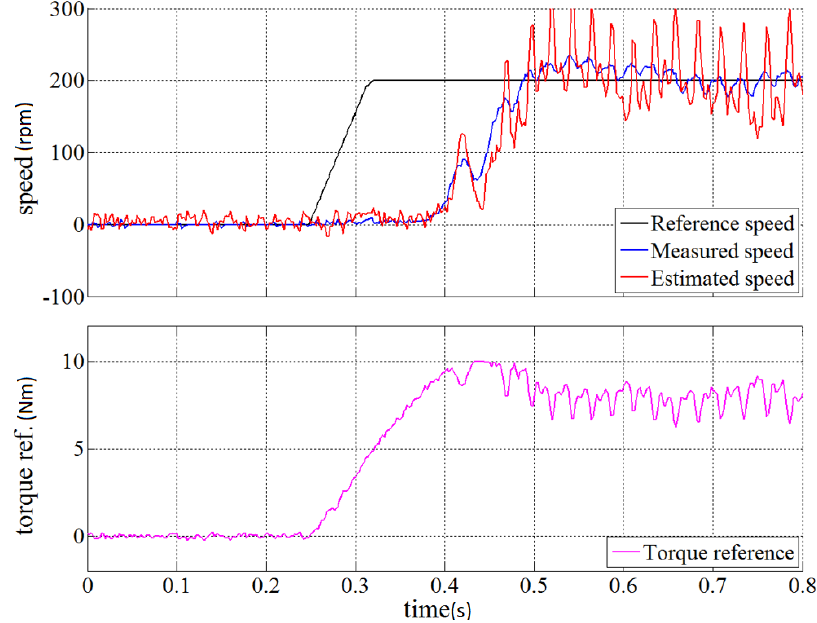
Figure 23. Motor #1: Increased bandwidth sensorless speed control (MTPA), startup from 0 to 200 rpm, typical (no adaptation) rotating voltage injection (70 V), 6 Nm load.